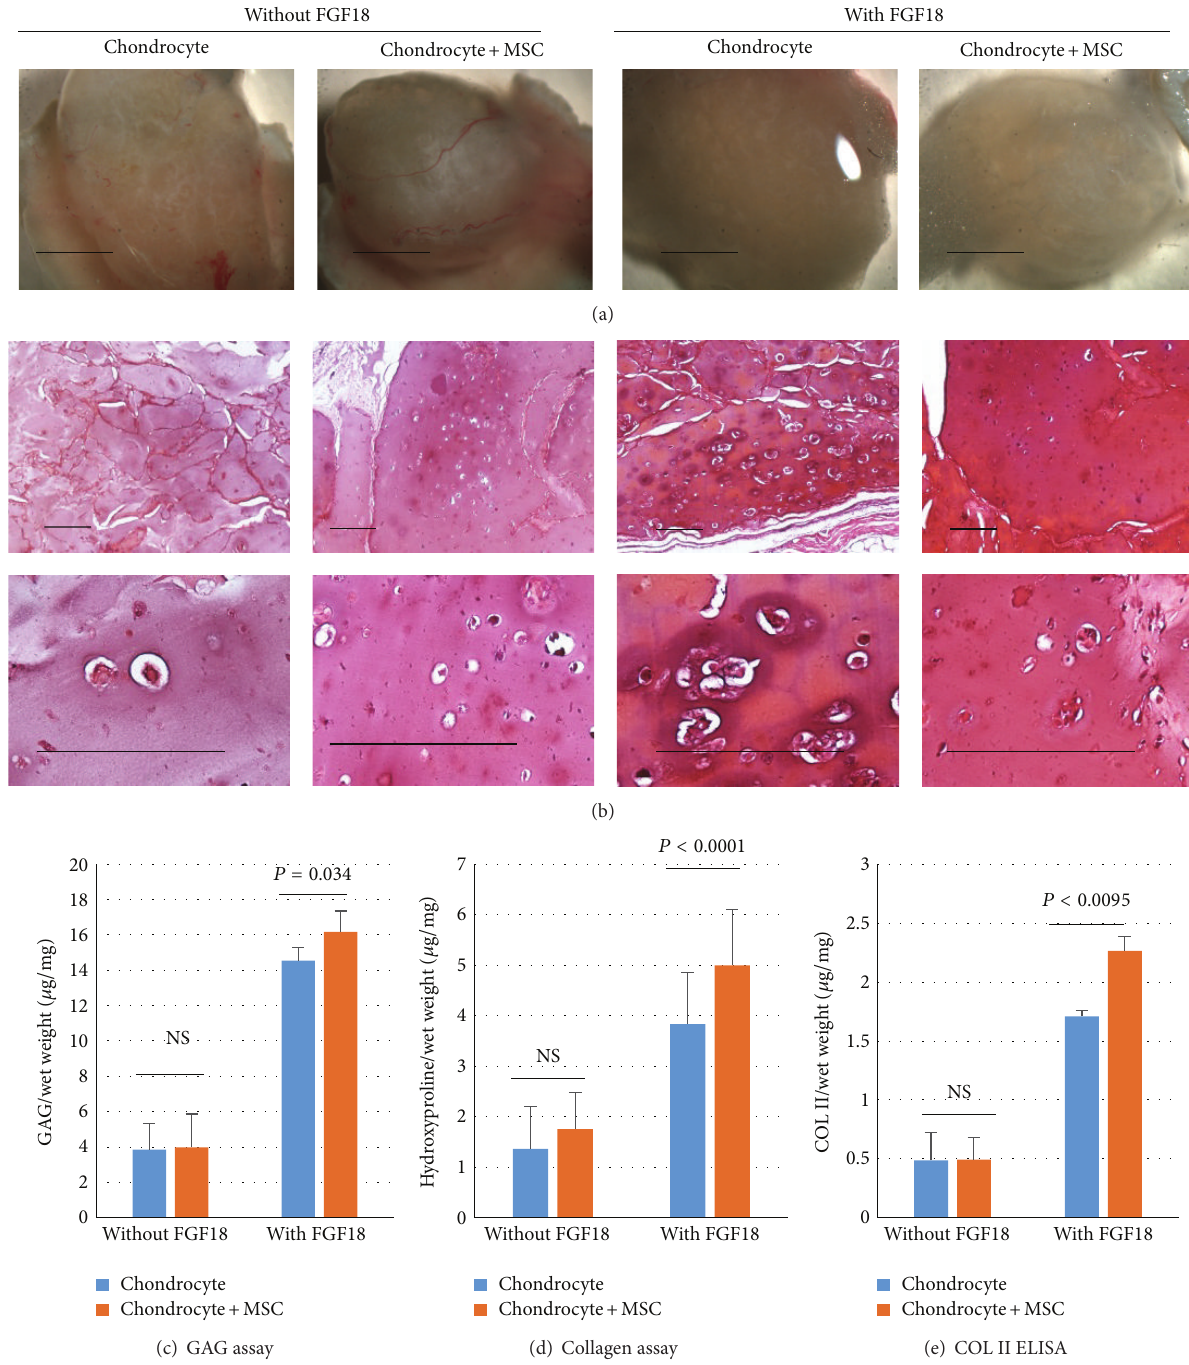
Figure 3: Coimplantation of MSCs and chondrocyte in alginate hydrogel subcutaneously in nude mice. (a) Overview of tissue engineering constructs containing chondrocytes only or mixture of MSC and chondrocyte. Hydrogel was loaded with or without FGF18 (10ng/mL). Bar = 5mm. (b) Tissue engineering constructs were sectioned and stained with Safranin O. Lower panel is the enlarged pictures of the inserts in upper panel. Bar = 50 𝜇 m. (c) GAGs were quantified in tissue engineering constructs GAG assay ( 𝑛 = 3 ). Total GAGs ( 𝜇 g) were